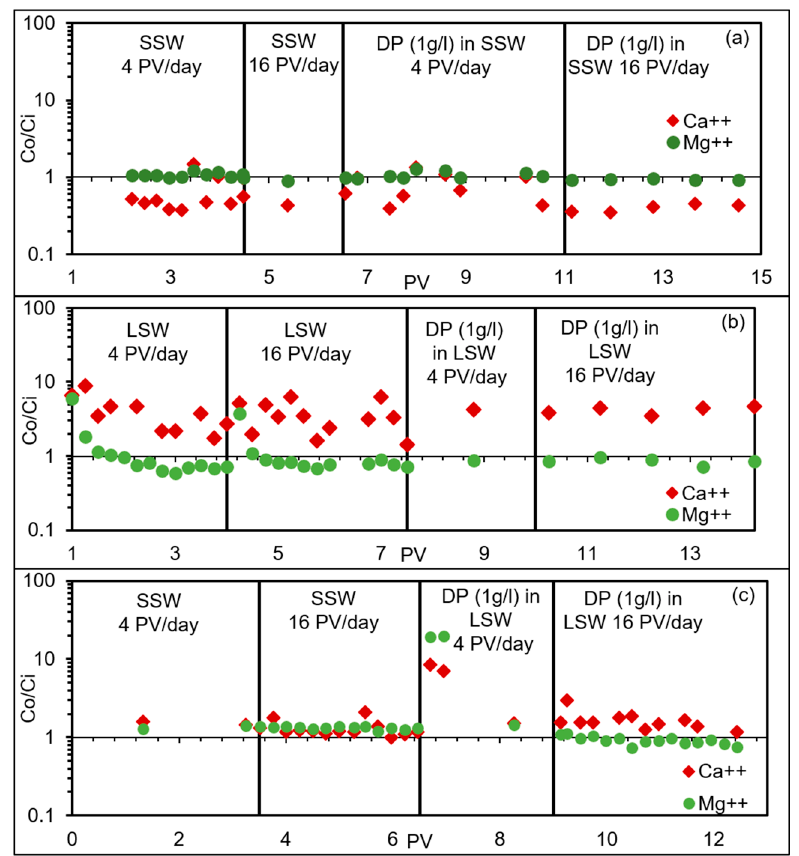
Figure 8. Effluent Ca 2+ and Mg 2+ concentrations for SK5-SSW ( a ), SK6-LSW ( b ) and SK7-mixed ( c